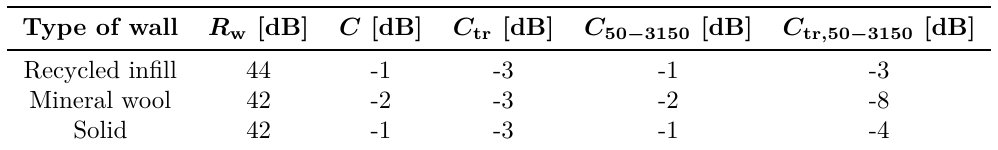
Table 3. Single number results for internal walls.